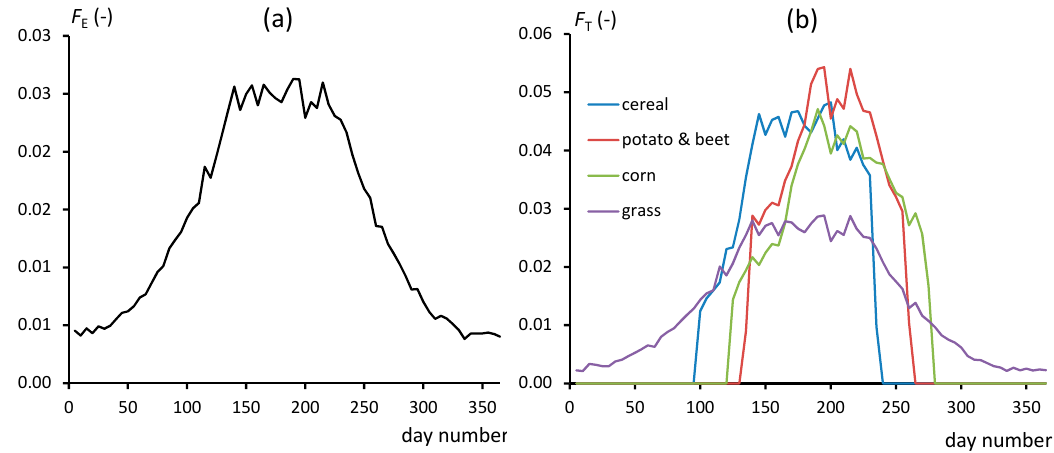
Figure 3. Multiplication factors to scale annual evapotranspiration figures for nature areas ( a ) and annual transpiration figures of major crops ( b ) to 5-day values. Based on simulations with the soil–water–atmosphere–plant model (SWAP; 2007–2013), using standard crop parameter values published in [28].